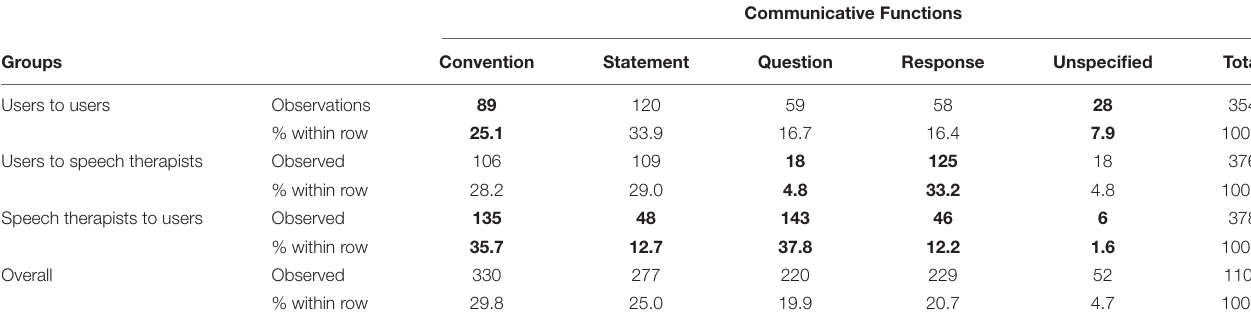
TABLE 3 | Contingency table of communicative functions by participant